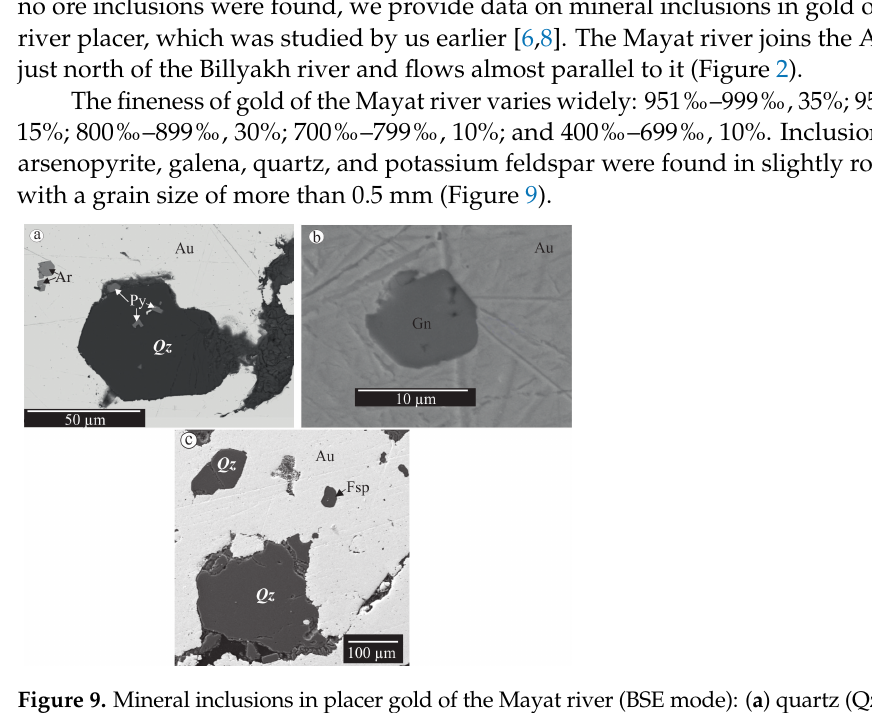
Figure 8. Morphology and internal structure of slightly rounded native gold of the Nebaibyt river placer: ( a , b ) slightly rounded gold; ( c ) block nature of the internal structure of multiphase gold, etched with a reagent based on aqua regia; ( a , b ) shot in SEI mode; ( c ) shot in BSE mode. No mineral inclusions were found in gold except for small inclusions of quar tz . Native gold is mainly represented by a lamellar morphology with a coarse, shagreen surface. Lamellar gold has a high fineness (900‰–999‰) and is characterized by a highly modified internal structure with recrystallization and granulation structures, and by thick high-grade margins and very high-grade intergranular veinlets (Figure 7). This indicates the repeated redeposition of gold from ancient intermediate sources into younger sediments.